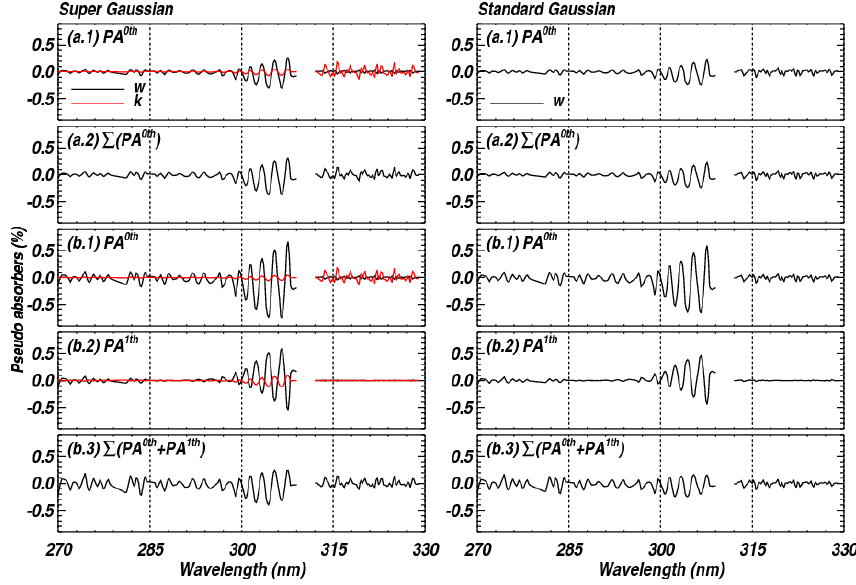
× (cid:49)p o and (a2) the sum of them for ∂p